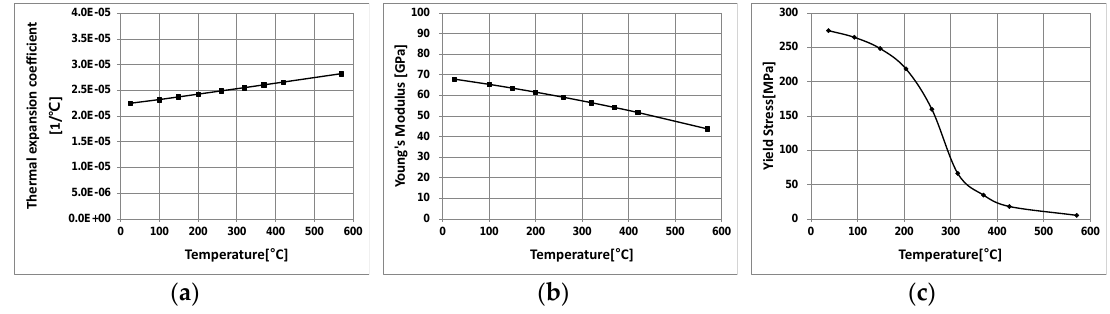
Figure 13. Temperature-dependent material properties for thermal elasto-plastic analysis: ( a ) thermal expansion coefficient; ( b ) Young’s modulus; ( c ) yield stress.